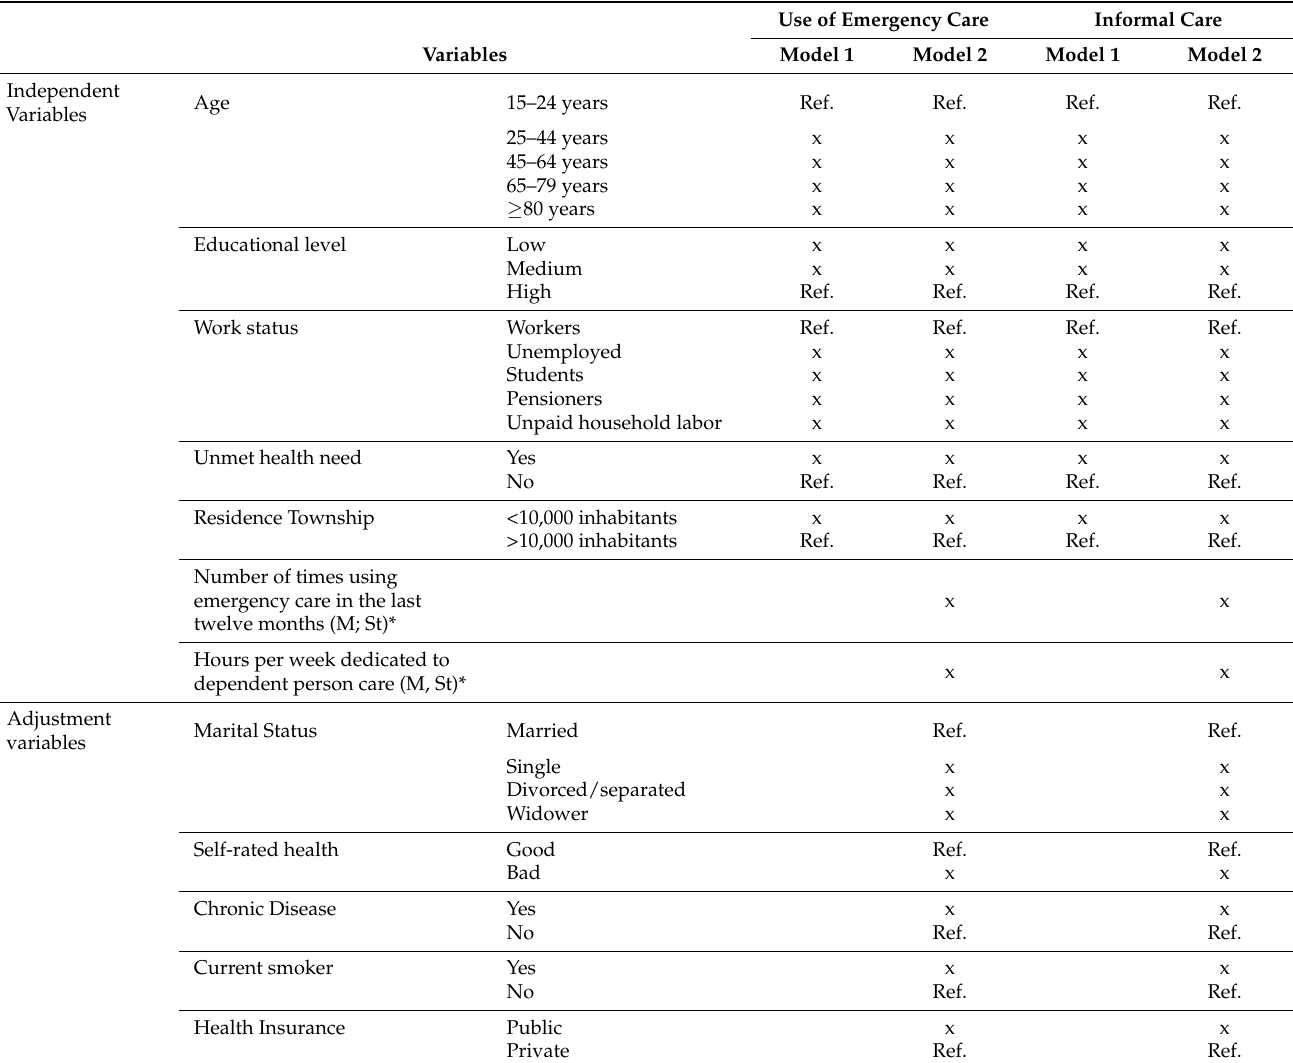
Ref.: reference category. Only Odds Ratios and CI 95% are presented in the results tables for the variables of interest related to gender determinants in the use of health emergency services and informal care (independent variables). The rest of the variables will not be shown in the results tables, as they are adjustment variables in the